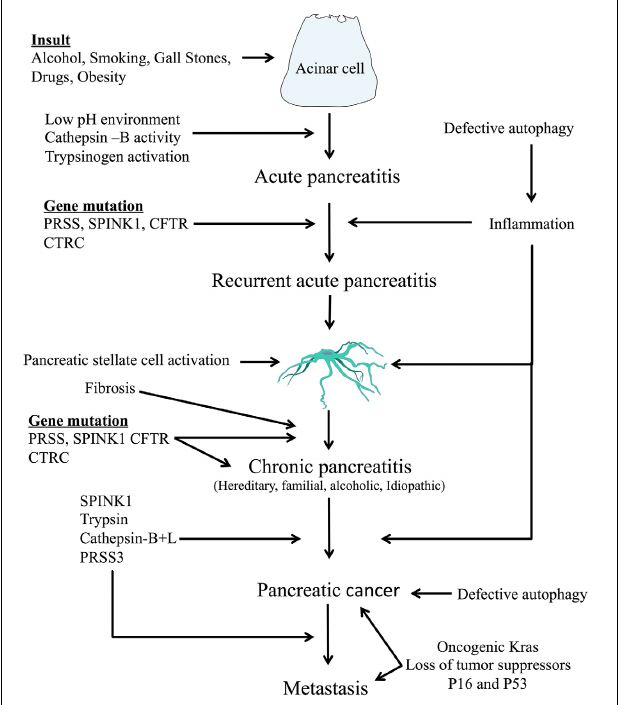
FIGURE 1 | Common pathways associated with disease progression from acute to chronic pancreatitis and pancreatic cancer. Pancreatitis starts with an initiating insult followed by changes in the cellular environment and premature digestive enzyme activation. Mutations of genes associated with trypsinogen activation/inactivation predispose the pancreas to development of disease. As disease progresses defective autophagy, increased inflammation, pancreatic stellate cell activation, and fibrosis occur. Advancement toward pancreatic cancer and metastasis is also associated with defective autophagy, as well as extracellular matrix degradation, cell proliferation, expression of oncogenic Kras and loss of tumor suppressors (e.g., P16 and P53). Autophagy and inflammation are discussed further in Figures 2 , 3